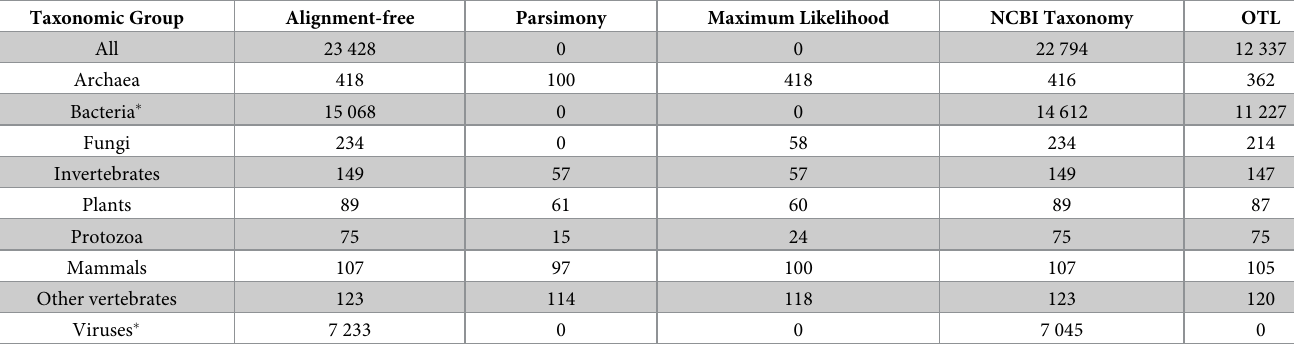
The alignment-free methods did not require any preprocessing of the coding sequences. Parsimony used a stricter preprocessing cutoff than maximum likelihood, and